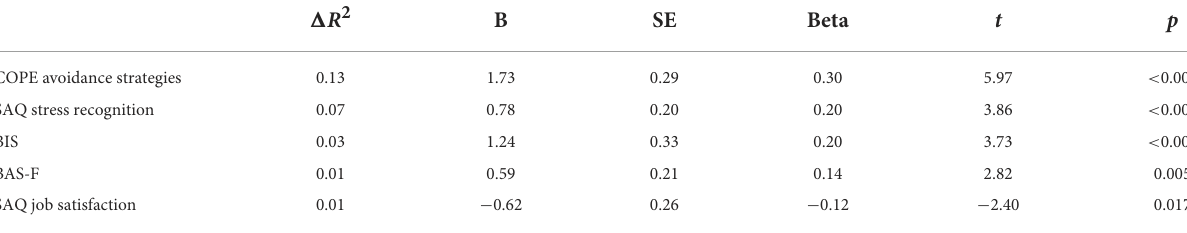
TABLE 4 Multiple linear regression model predicting the emotional distress index.